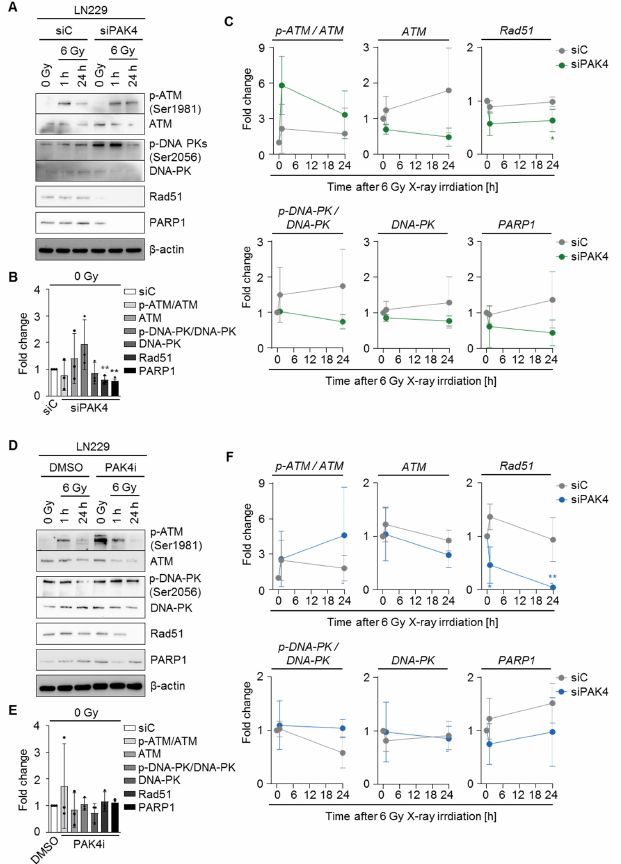
Figure 5. PAK4 regulates the expression of key DNA repair proteins. ( A ) Representative Western blot images of the phosphorylation and expression of the indicated DNA repair proteins in dependence on siC or siPAK4#1 in unirradiated LN229 cells and after 1 and 24 h of 6 Gy X-ray irradiation. ( B , C ) Quantification of the phosphorylation and expression levels of the indicated DNA repair pro- teins after siPAK4#1 treatment in ( C ) unirradiated and ( D ) irradiated LN229 cells. Values are de- picted as fold changes of siC. ( D ) Western blot analysis of the phosphorylation and expression of the indicated DNA repair proteins in dependence on DMSO and PAK4i in unirradiated LN229 cells and after 1 and 24 h of 6 Gy X-ray irradiation. ( E , F ) Quantification of the phosphorylation and ex- pression levels of the indicated DNA repair proteins after PAK4i treatment in ( E ) unirradiated and ( F ) irradiated LN229 cells. Values are depicted as fold changes of DMSO. ( B , C , E , F ) Data show means +/ − SDs (N = 3 independent experiments, t -test, * p < 0.05, ** p < 0.01).